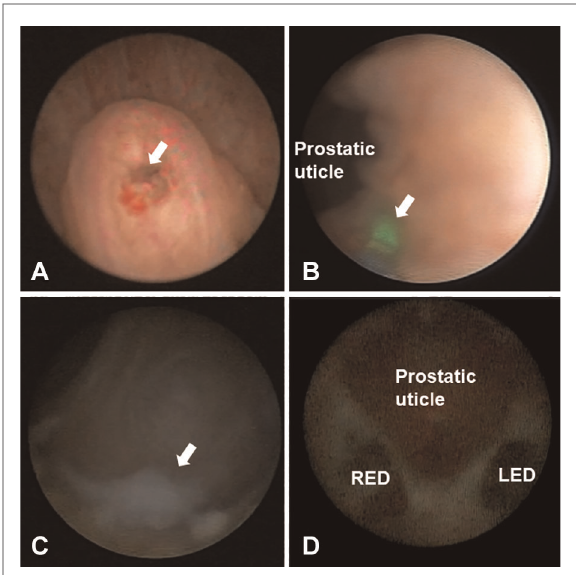
FIGURE 1 Intraoperative view of seminal vesiculoscopy in patients with ejaculatory duct obstruction. ( A ) The arrow shows the opening of verumontanum. ( B ) The arrow shows the low-energy holmium laser were used at fi ve o ’ clock of the prostatic utricle neck to help fi nd the ejaculatory duct opening. ( C ) The arrow shows white seminal fl uid in the seminal vesicle. ( D ) The relationship between the prostatic utricle and the opening of ejaculatory duct. LED, left ejaculatory duct; RED, right ejaculatory